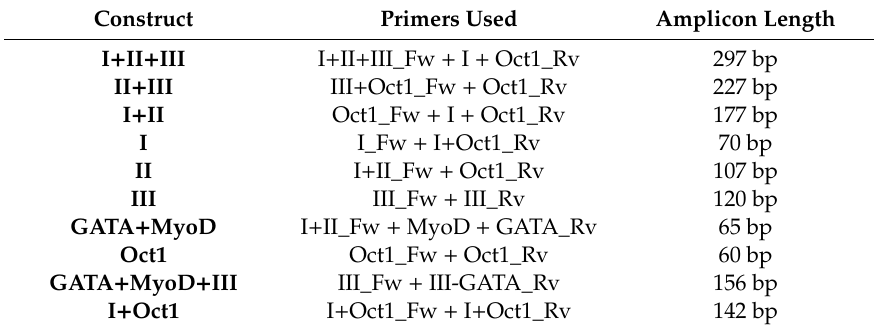
Table 2. Primers used for the amplification of luciferase plasmids, and length of the expected amplicon. Below is displayed the primers in the DNA sequence of regions